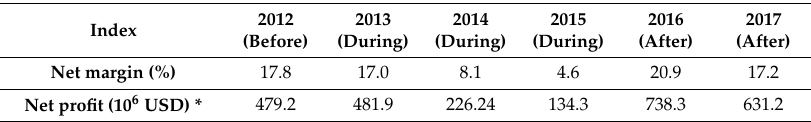
Table 1. Sao Paulo Water Utility Company (SABESP) net margin and net profits under the last drought condition scenario [12,28].